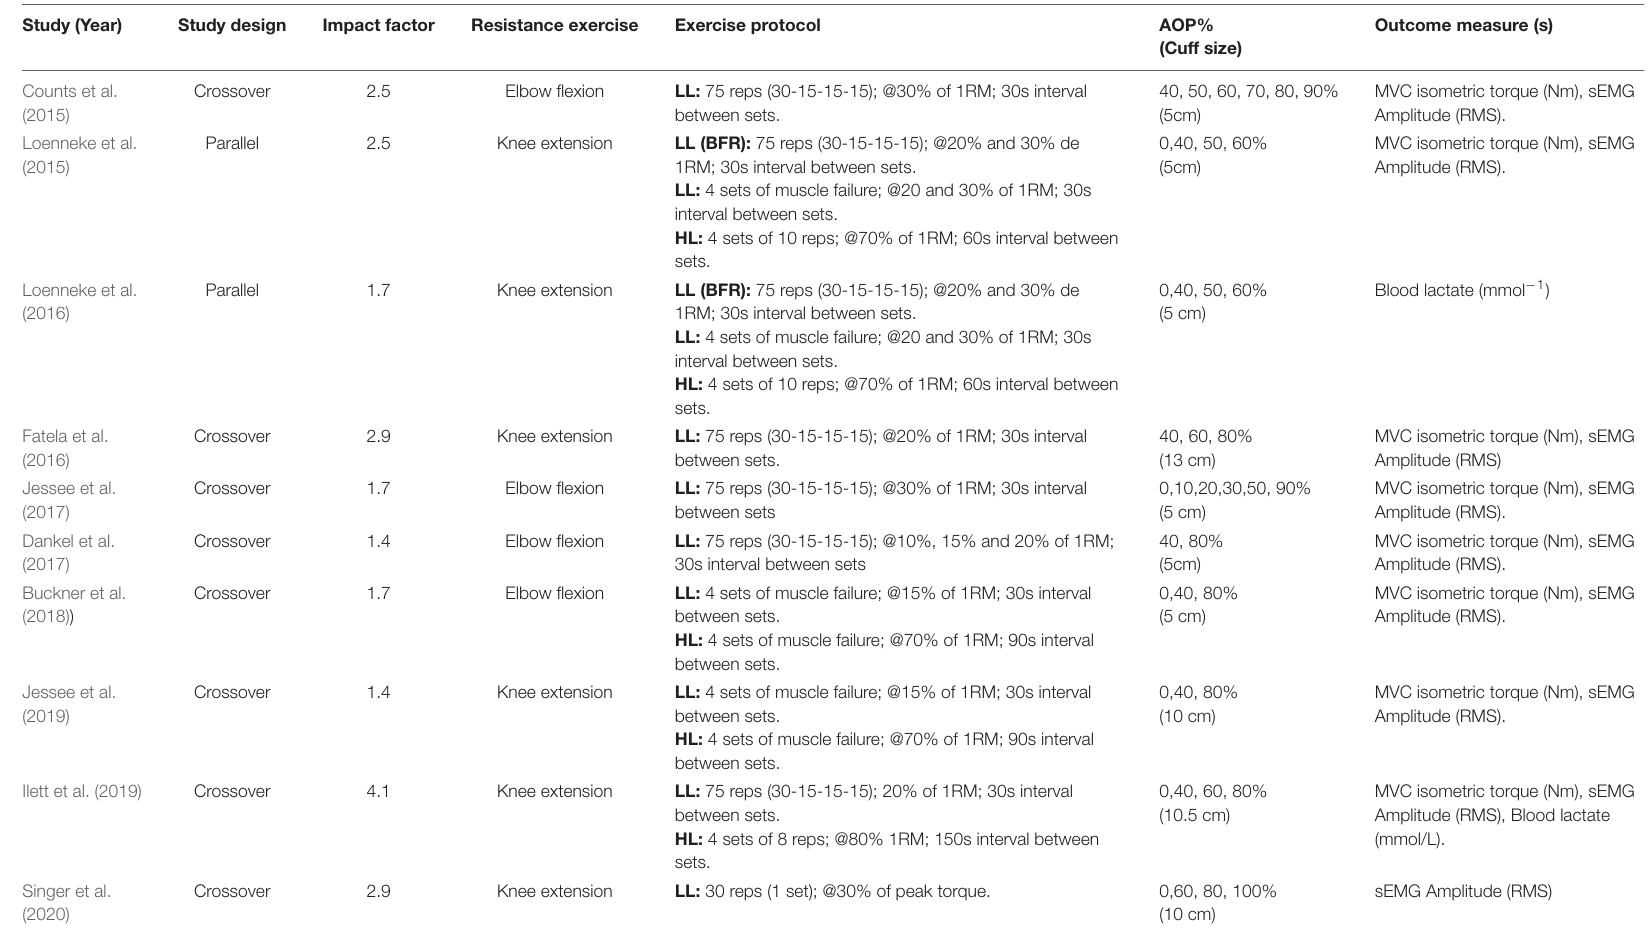
TABLE 3 | Summary and characteristics of the studies included in the